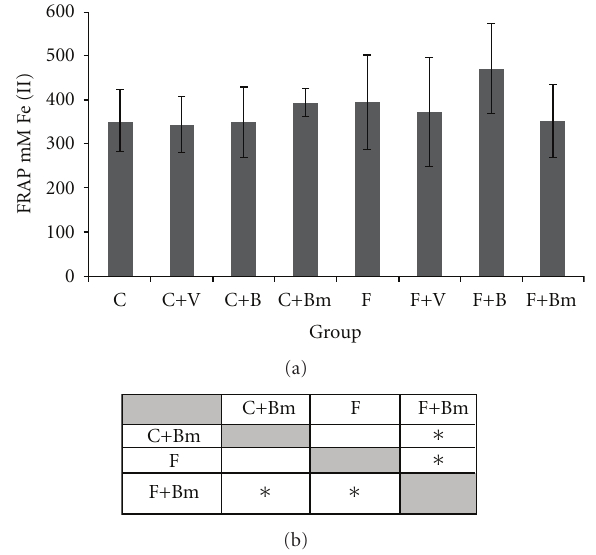
Figure 6: E ff ects of vanadium complex V, B, and Bm on plasma FRAP of Wistar rats. Data are presented as mean ± SD for n = 6. (b) Statistical di ff erences between groups P < 0.05.